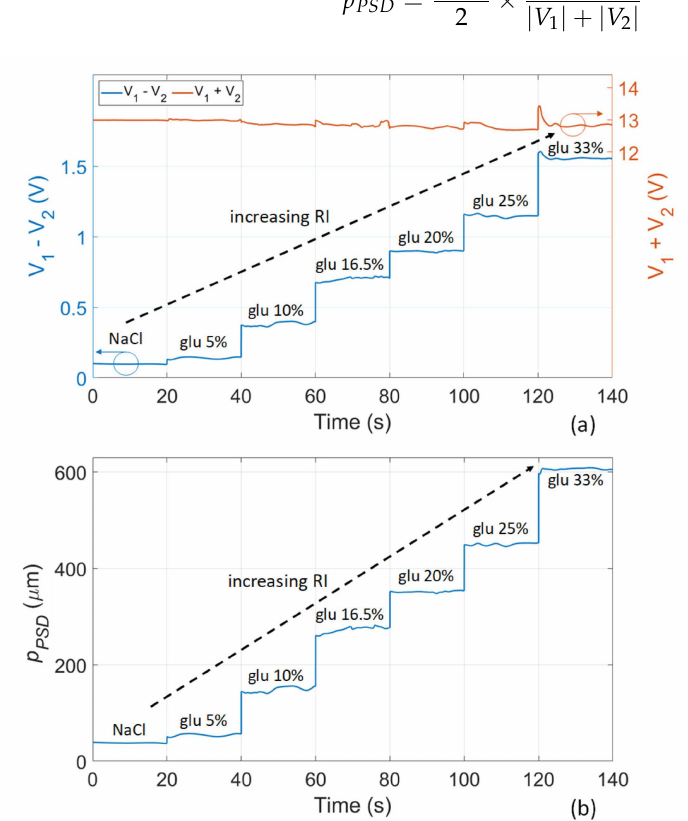
Figure 4. Experimental signals in the time domain obtained during calibration of the optofluidic platform with NaCl and glucose–water samples: ( a ) difference V 1 − V 2 (blue trace) and sum V 1 + V 2 (orange trace); ( b ) position of the laser beam p PSD measured by the PSD and retrieved by computing Equation